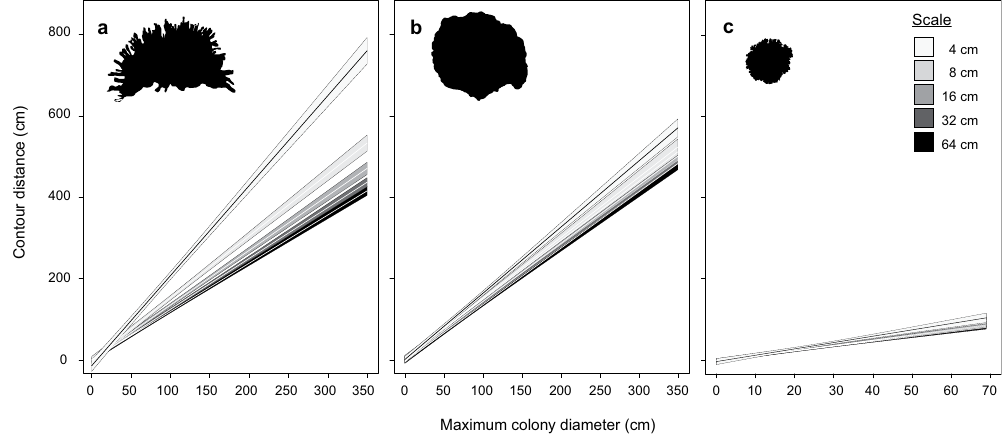
Figure 5. Relationships between maximum colony diameter (cm) and contour distance travelled by measuring wheels of diameters 4–64 cm ( ± 95% confidence intervals): ( a ) Porites cylindrica (R 2 = 0.93–0.97); ( b ) massive Porites (R 2 = 0.95–0.97); and ( c ) Pocillopora damicornis (R 2 =